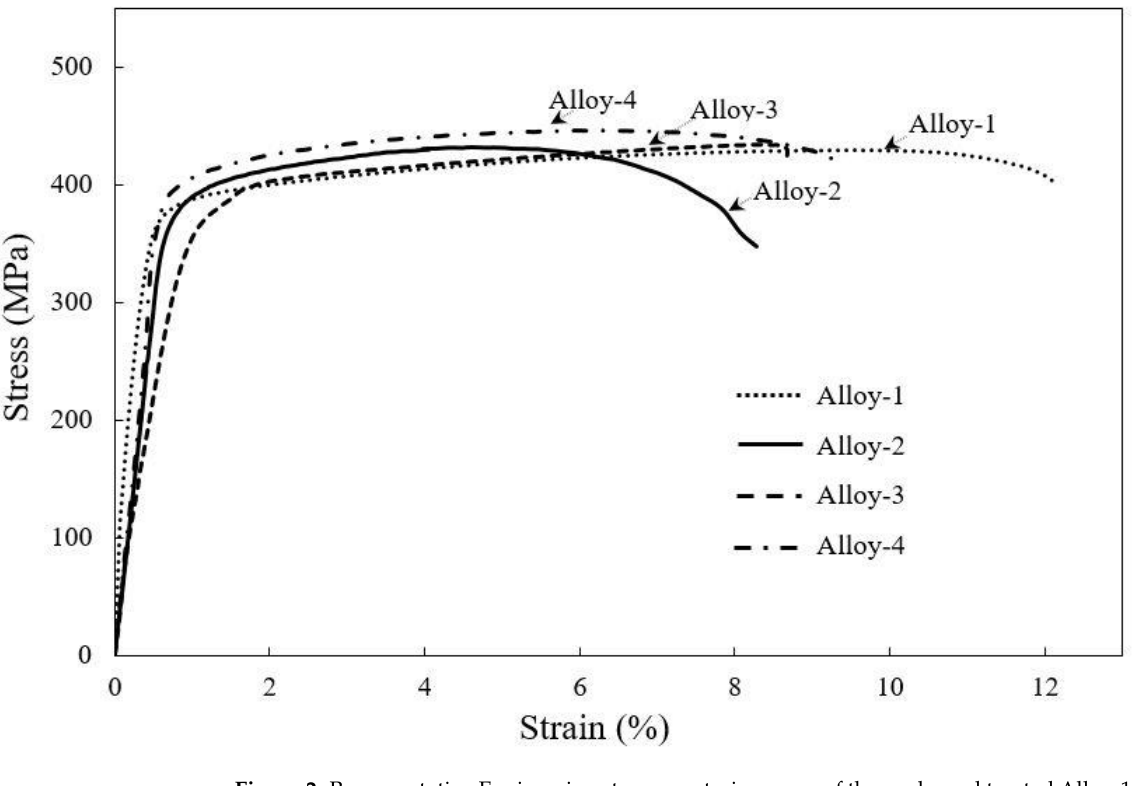
Figure 2. Representative Engineering stress vs. strain curves of the peak aged treated Alloy-1, Alloy-2, Alloy-3 and Alloy-4 specimens. Table 2. Comparison of hardness values (HV) and ultimate tensile strength ( σ UTS ) of the presently studies alloys with some traditional Al-based alloys in medical